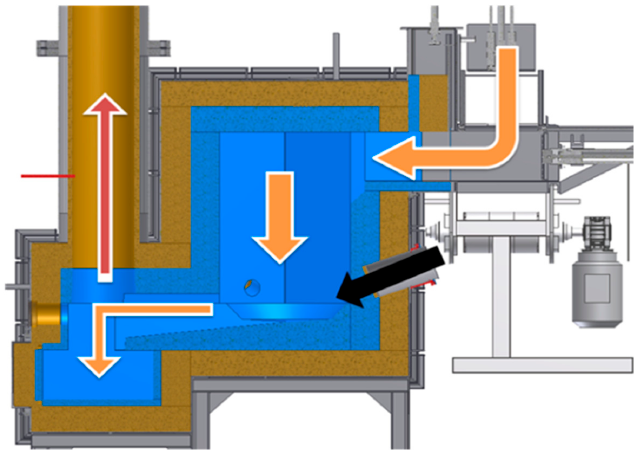
Figure 4. Cross-section through the plasma reactor with depiction of material flow. Waste and molten product–orange arrows, plasma stream–black arrow, fumes–red arrow.